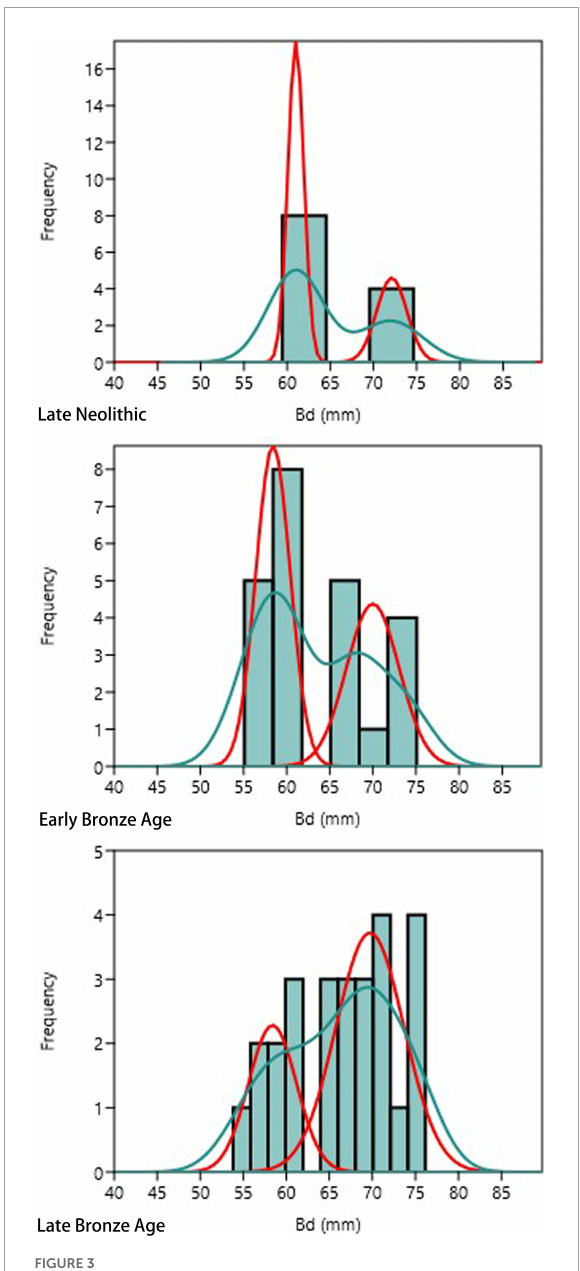
FIGURE3 Histograms with Kernel density curves (green) showing the distribution of metacarpal Bd of cattle from the Late Neolithic to the Late Bronze Age and the results of mixture analysis modeling grouping